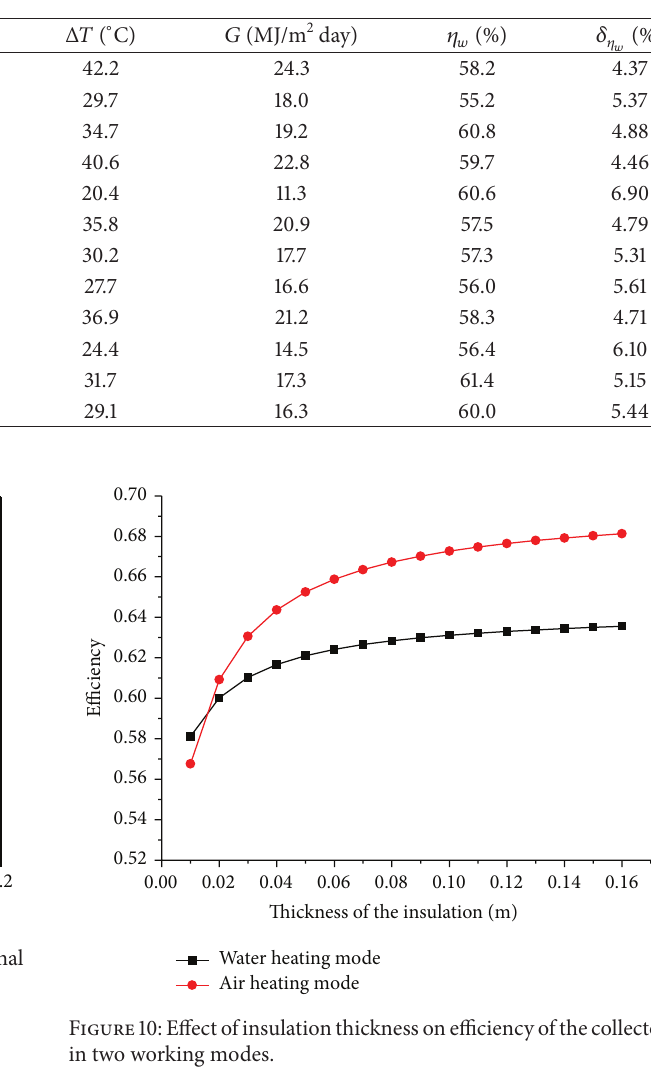
Table 3: Water heating efficiency of the collector in different days.